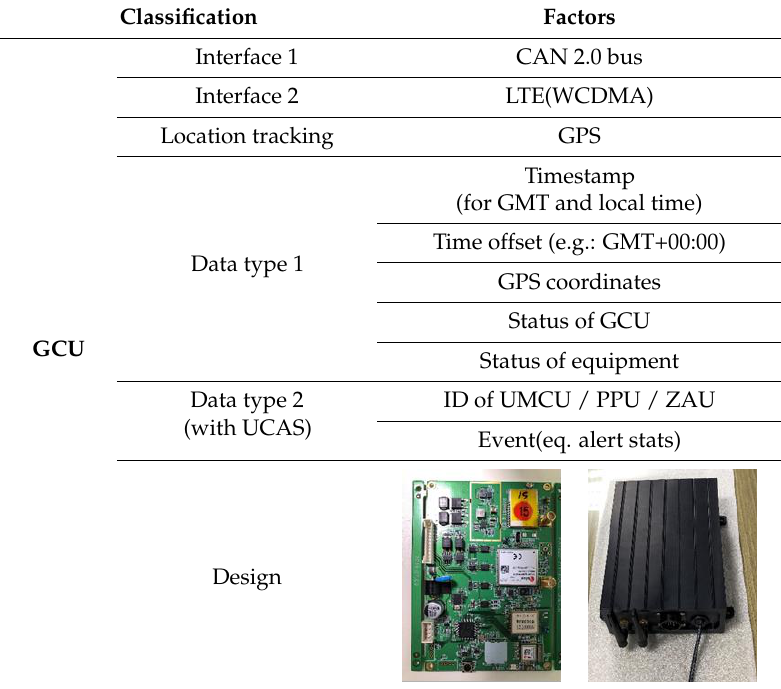
* GMT: coordinated universal time.